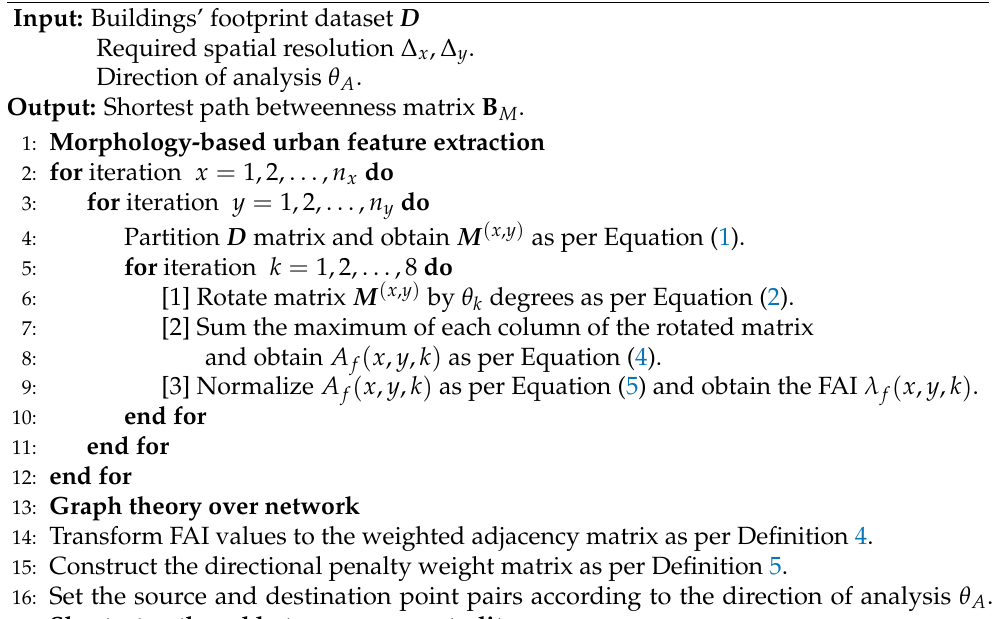
Algorithm 1 Urban Wind Corridors Analysis via Network Theory